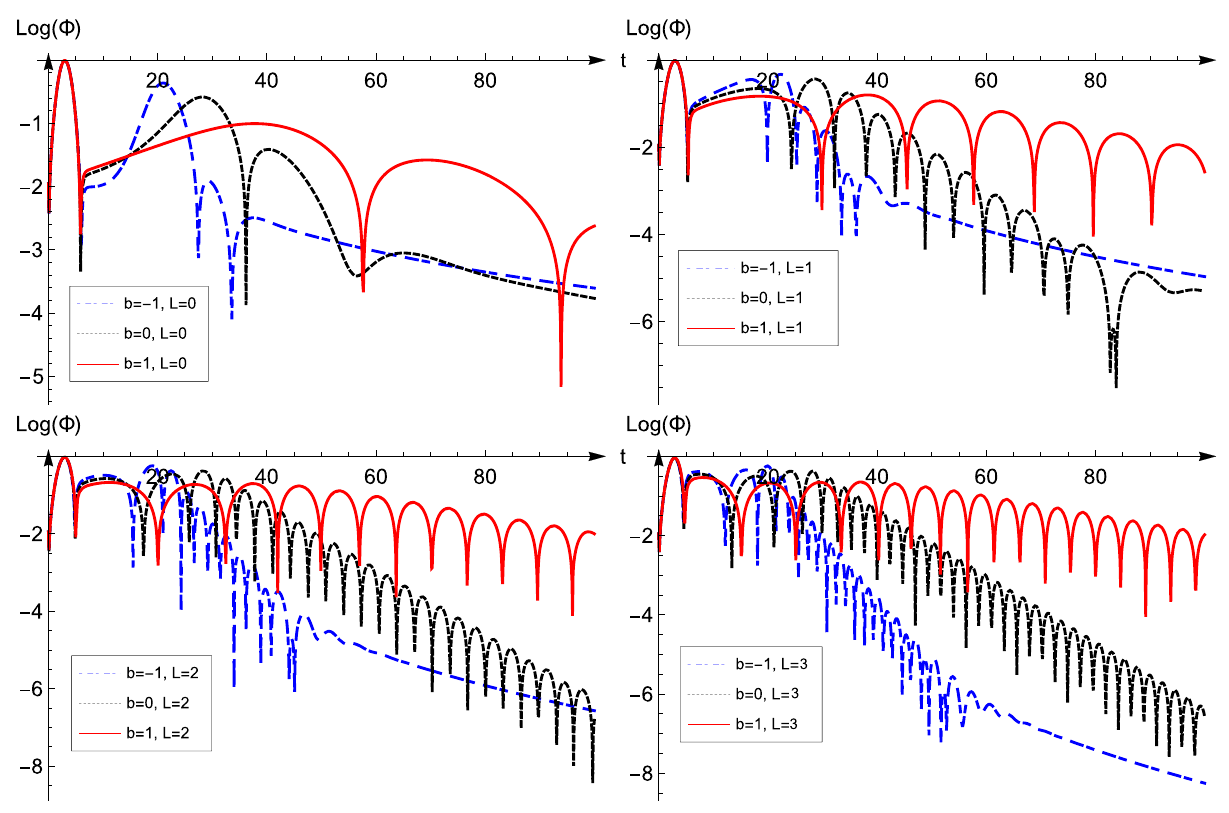
Fig. 13 Dynamical evolution of a scalar field perturbation to the black hole